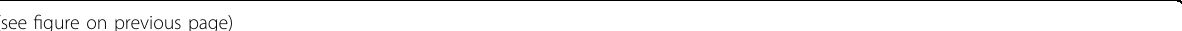
Fig. 2 G-MDSCs from aging mice induce cardiac fi brosis. Adoptive transfer of G-MDSCs (1 × 10 7 ) was performed in young mice (6 weeks) every 5 days for 40 days. Echocardiography, pathological examination, and qPCR were performed in young mice, old mice (20 months), and young mice that were administered G-MDSCs. A – D Left ventricular ejection fraction (LVEF; A ), LV end-systolic diameter (LVDs; B ), LV dp/dTmax ( C ), and LV dp/ dTmin ( D ) of the young mice, aging mice, and young mice with G-MDSCs; n = 5 per group. E WGA staining revealed the cardiomyocyte cross- sectional area of the young mice, aging mice, and young mice with G-MDSCs. Representative cytograms are shown on the left, and statistical data are shown on the right; n = 4 per group. Scale bars, 50 μ m. F Masson staining revealed fi brotic tissue in the mouse hearts. Representative cytograms are shown on the left, and statistical data are shown on the right; n = 4 per group. Scale bars, 50 μ m. G The ratio of α -SMA + fi broblasts detected by fl ow cytometry of the young mice, aging mice, and young mice with G-MDSCs. Representative cytograms are shown on the left, and statistical data are shown on the right; n = 4 per group. H – J The mRNA levels of fi brosis markers (Col1a1, Col3a1, Postn, and Acta2; H ), fi brosis-related factors (Mmp2, Mmp9, Timp1, Lox, Lgals3, and Tcf21; I ), and cytokines (IL6, IL1b, IL10, and Tgf β 1; J ) in the hearts of the young mice, aging mice and young mice with G-MDSCs; n = 4 per group. The data are presented as the means ± SDs. Differences were determined by one-way ANOVA (for more than 2 groups), and Tukey ’ s HSD post hoc test was performed. * P <